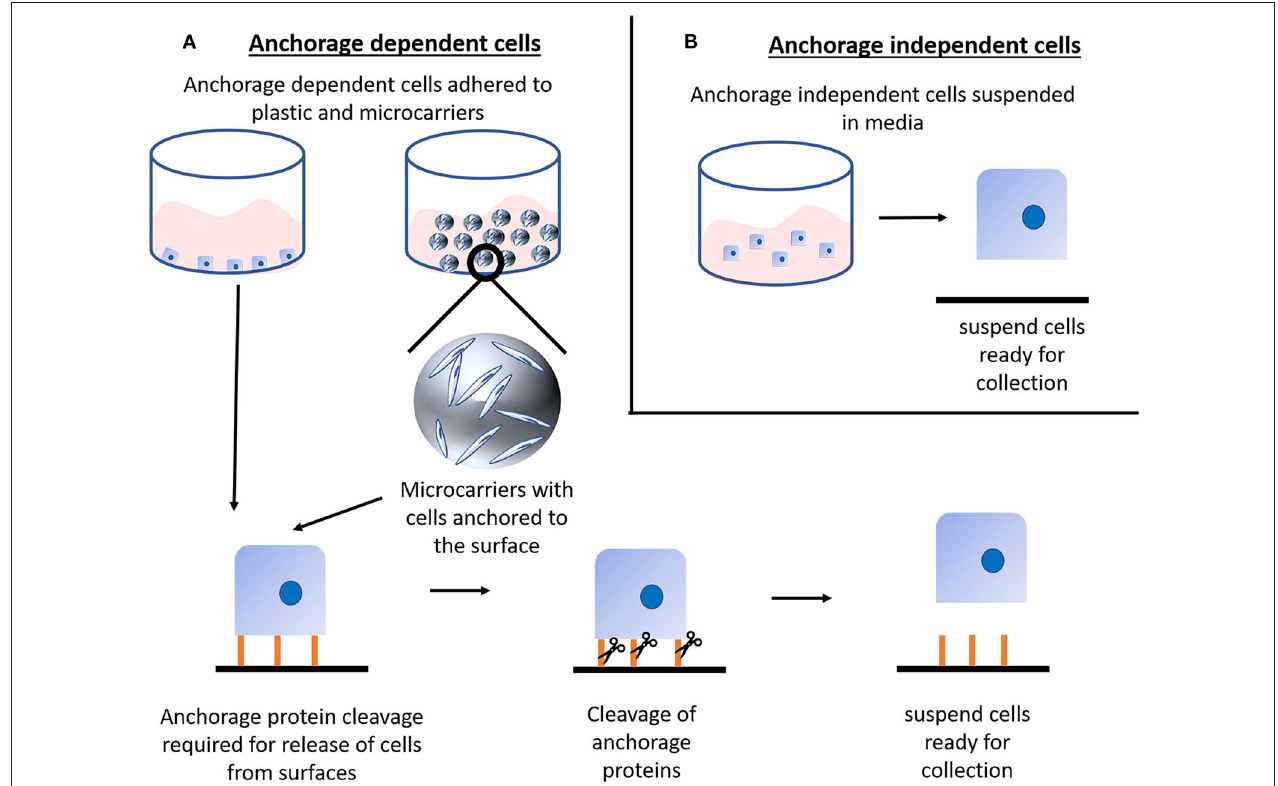
FIGURE 1 | Cell harvesting: (A) Anchorage dependent (adherent) cells require adherence to a surface for sustained and healthy culture, this anchorage can be to either common tissue culture plastics or to microcarriers. Although microcarriers themselves are in suspension it is important to note that the cells are still anchored to the microcarrier and thus require the same cleavage of anchorage proteins as cells anchored to tissue culture plastics. Classically, anchorage proteins are cleaved either via enzymatic or mechanical means. Such cleavage releases the cells from the surface and into suspension for collection. Anchorage dependent cells typically cannot survive long in suspension conditions, hence the requirement for batch cleavage. (B) Anchorage independent (suspension) cells do not require surface adherence to be viable and proliferate, thus they are readily available for collection and easily adaptable to